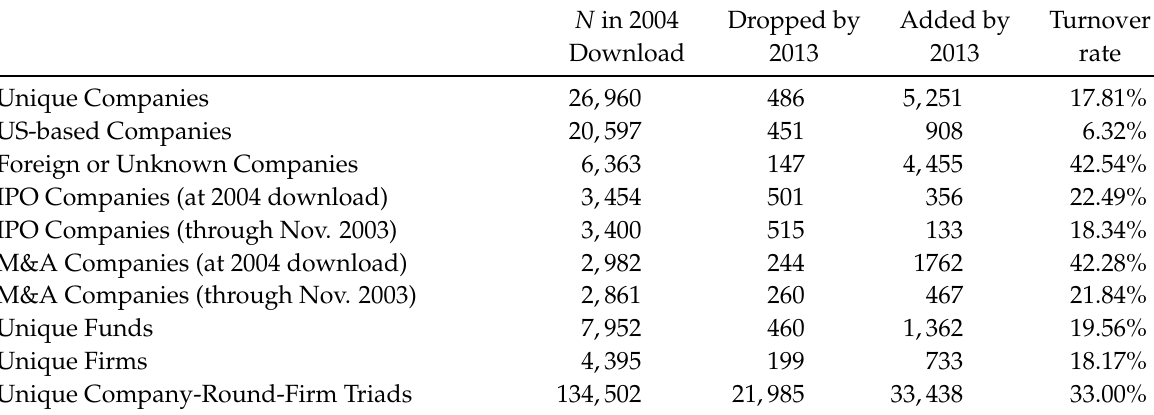
Table 4: Comparison of September 2004 and October 2013 downloads for 1980–1999 investment